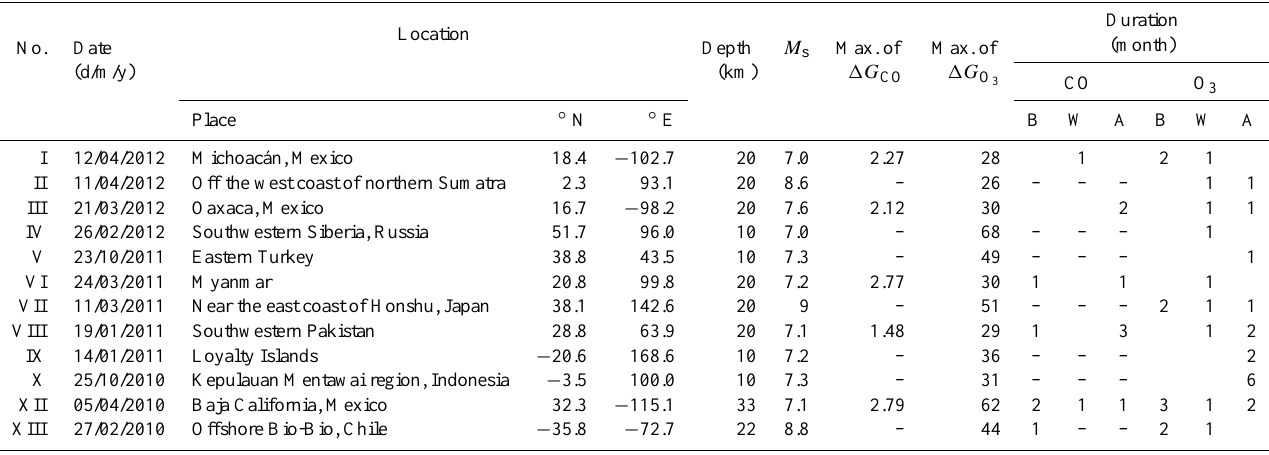
Table 2. General parameters of the studied earthquakes and features of CO and O 3 anomalies.